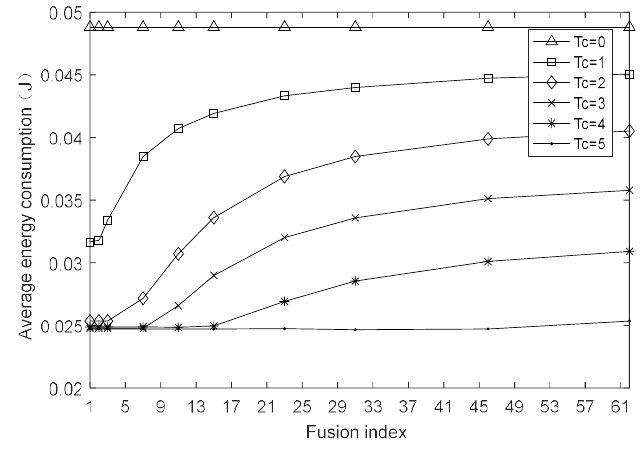
Figure 4. Average energy consumption with varying fusion index.